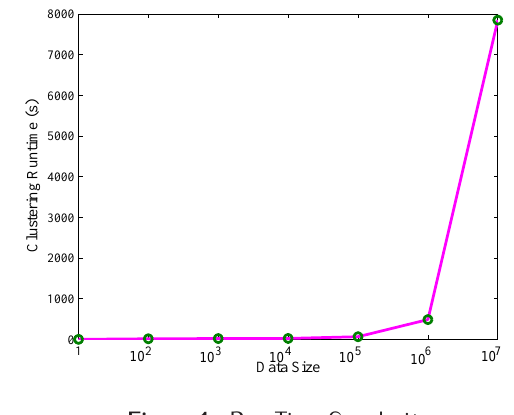
Figure 1. Run Time Complexity